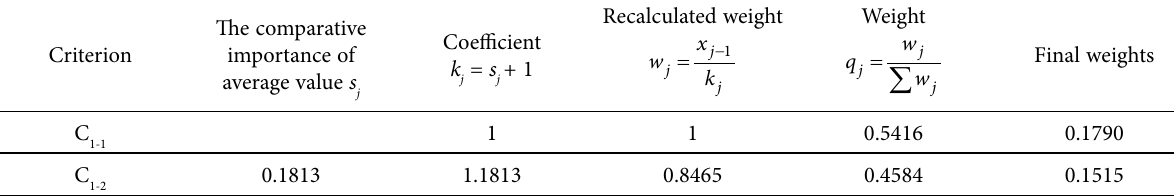
Table 6. Final results of SWARA method in weighting sub-criteria of environmental